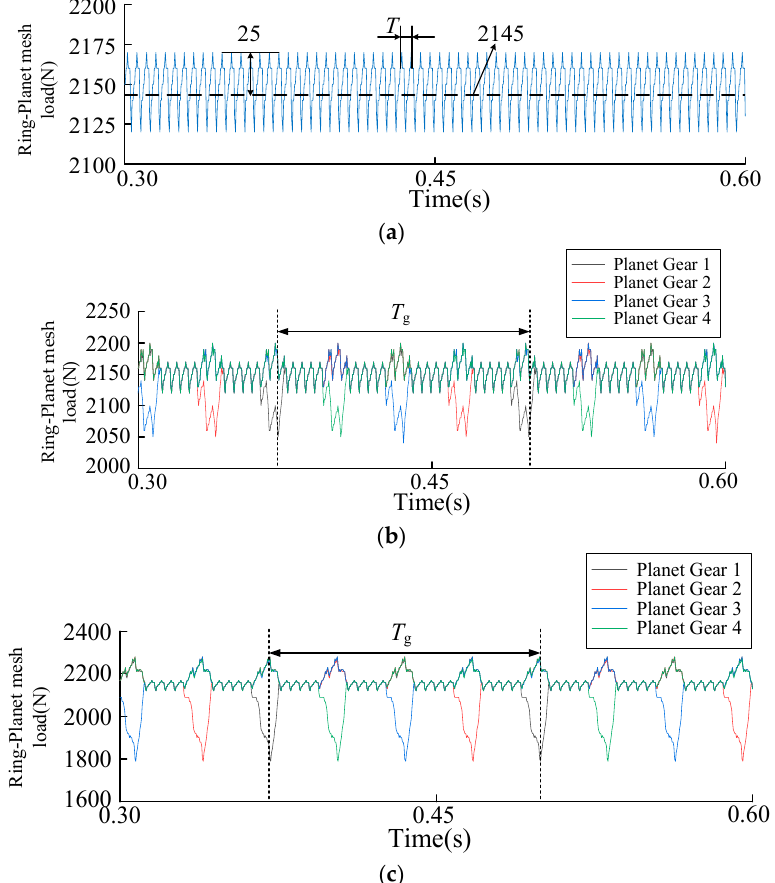
Figure 8. ( a ) Time domain history of the normal dynamic loads. ( b ) Time domain history of the shallow crack dynamic load. ( c ) Time domain history of the deep crack dynamic excitation.